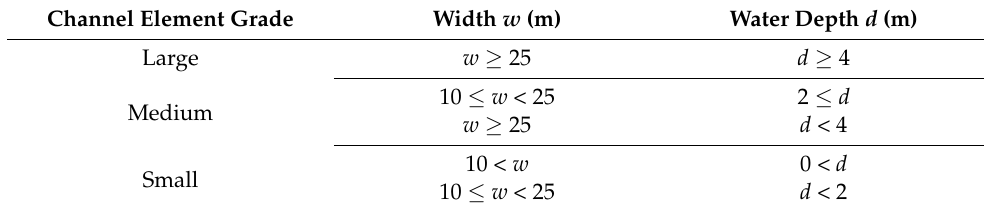
Table 7. Grading standards for the channel elements.